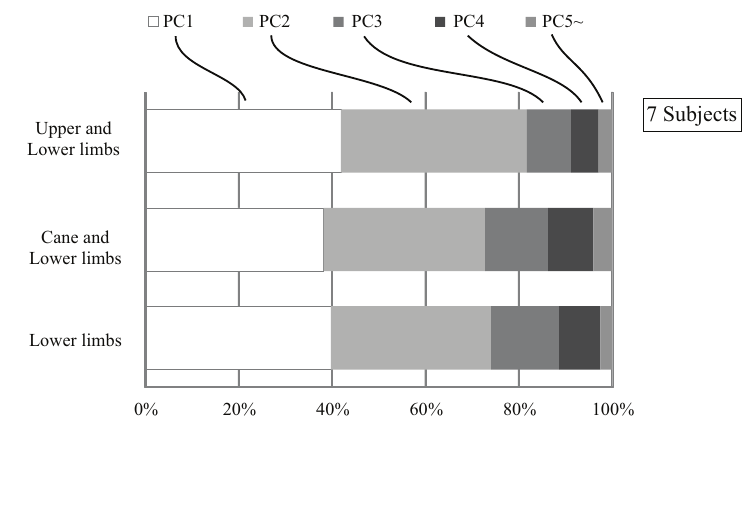
Figure 3. Group mean ratios of the first 4 principal components to the overall data for three sets of variables: ( i ) upper and lower limbs; ( ii ) cane and lower limbs; ( iii ) lower